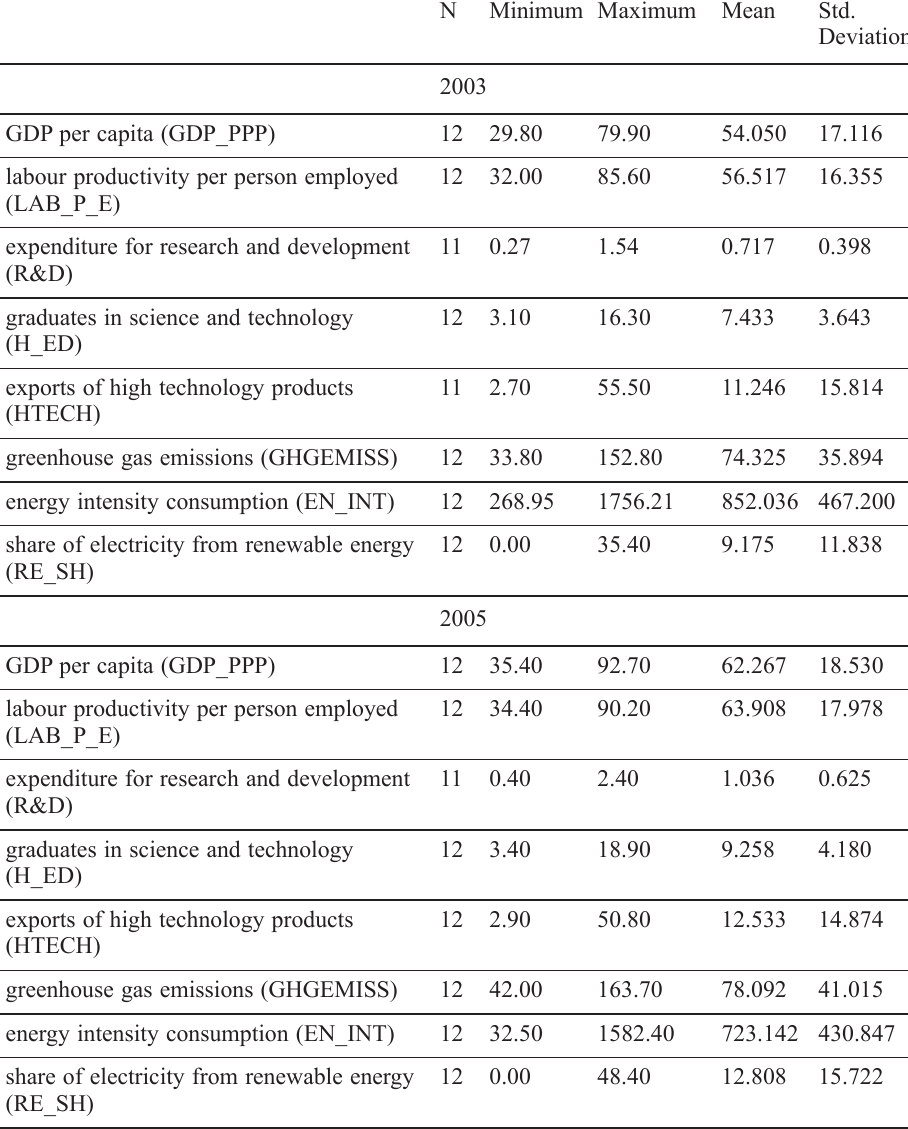
Table 3 . Descriptive statistics of the analyzed structural indicators’ variables for the new EU-12 countries in 2003 and 2005 N Minimum Maximum Mean Std.